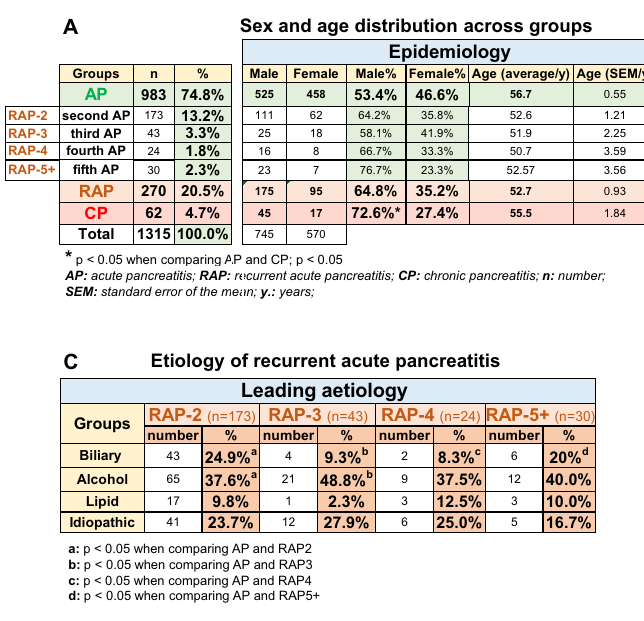
Figure 1. Epidemiology and etiology of pancreatitis in the study population. ( A ) Sex and age distribution across groups. ( B ) Etiology of pancreatitis across study cohorts. ( C ) Etiology of recurrent acute pancreatitis